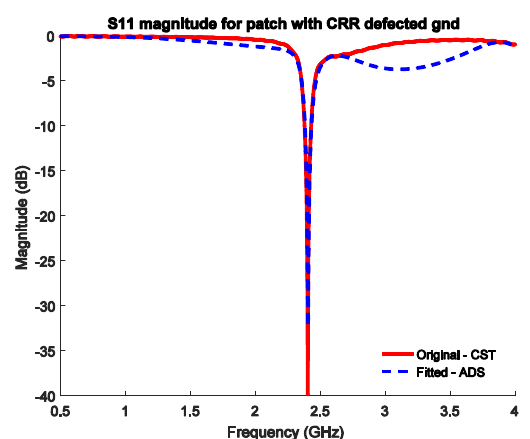
Figure 15: S11 original and fitted magnitude for patch with CRR.